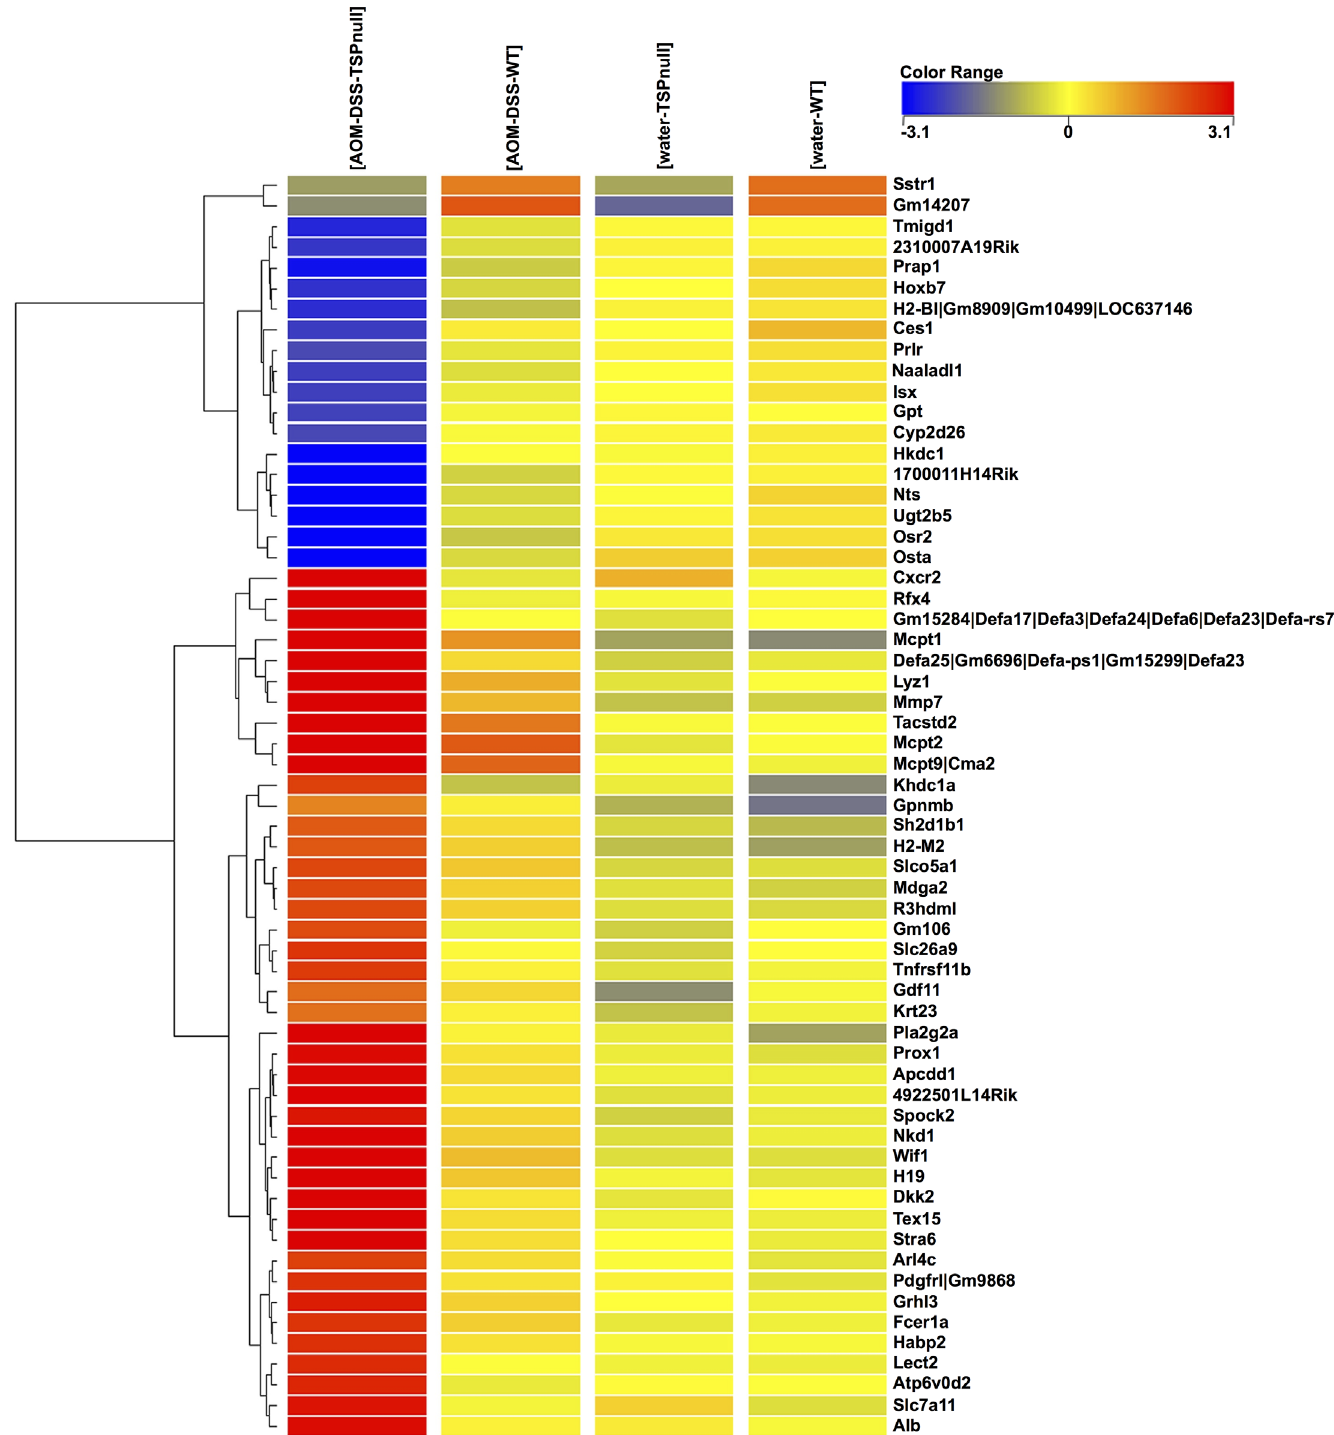
Fig 3. Heatmap of the 61 highly deregulated genes in the AOM-DSS treated mice. A fold-change cutoff of > = 2.0 was used and 342 differentially expressed genes in the treated (tumors) vs. untreated TSP-1 -/- (colonic tissue) were detected. In comparing TSP-1 -/- to WT tumors, 183 genes were differentially expressed. At a fold-change cutoff of > = 5.0, for the four pairwise comparison, 42 genes showed increased expression and 19 showed lowered transcript levels (p-value < 0.05). Rfx4 (regulatory factor X, 4) and Osr2 (odd-skipped related 2) showed the highest differential expression in the treated groups, TSP-1 -/- vs. WT, with Rfx4 expression enhanced by FC = 83.3 and Osr2 expression reduced by FC = 13.3. Transcripts from inhibitors of the Wnt